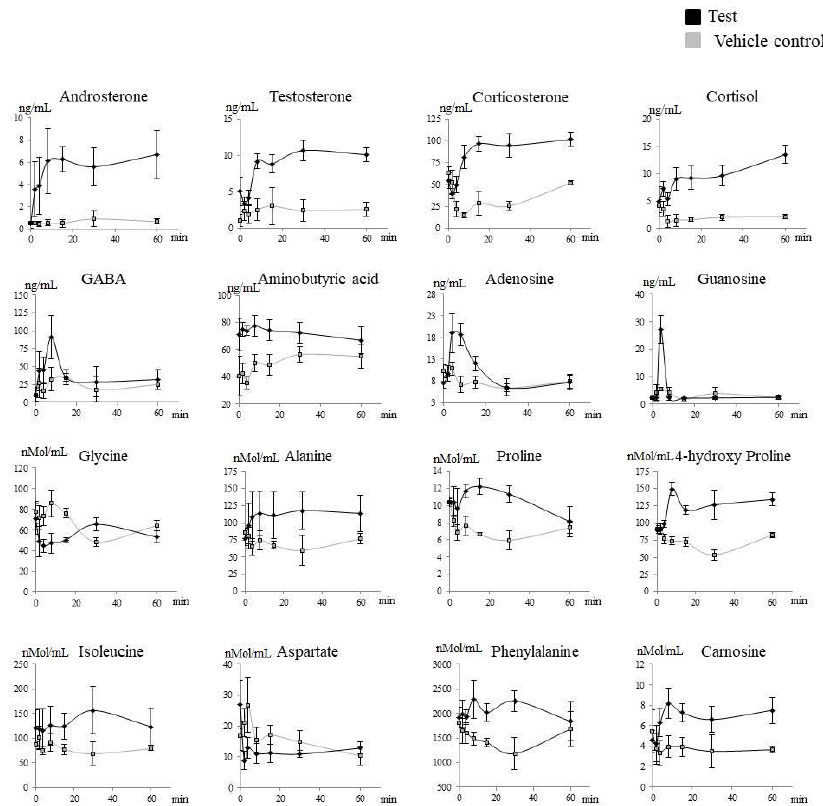
Figure 4. Targeted metabolites that significantly changed after Prostanit administration. Treated (black) versus vehicle control (gray) groups. X-axis, time after the drug administration. Y-axis, the content of the appropriate metabolite in rabbit plasma. The assessment of the areas under the curve in treated and vehicle control groups using the Shapiro–Wilk test with the consequent discrimination of those significantly di ff erent using the Student t -test or equivalent non-parametric Mann–Whitney U test (in accordance with their distribution).